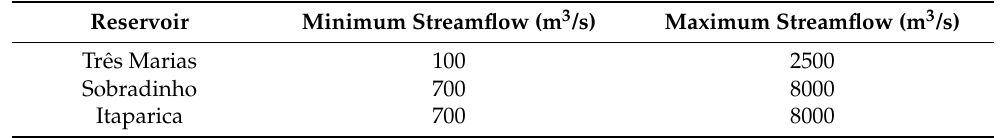
Table 3. Operating restrictions downstream of the